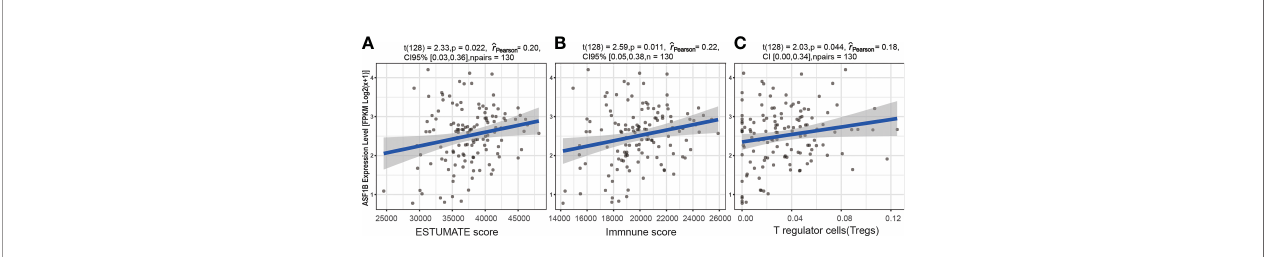
FIGURE 8 | The association between the ASF1B expression level and immune cell in fi ltration. Relationship between the ESTIMATE score and ASF1B expression level (A) , between the immune score and ASF1B expression level (B) , and between T regulatory cells (Tregs) and the ASF1B expression level (C)